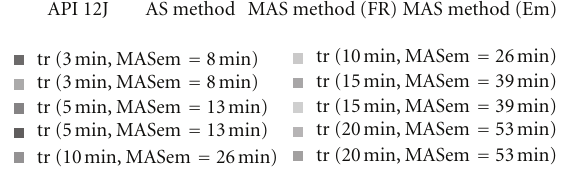
be downsized (based on the maximum required